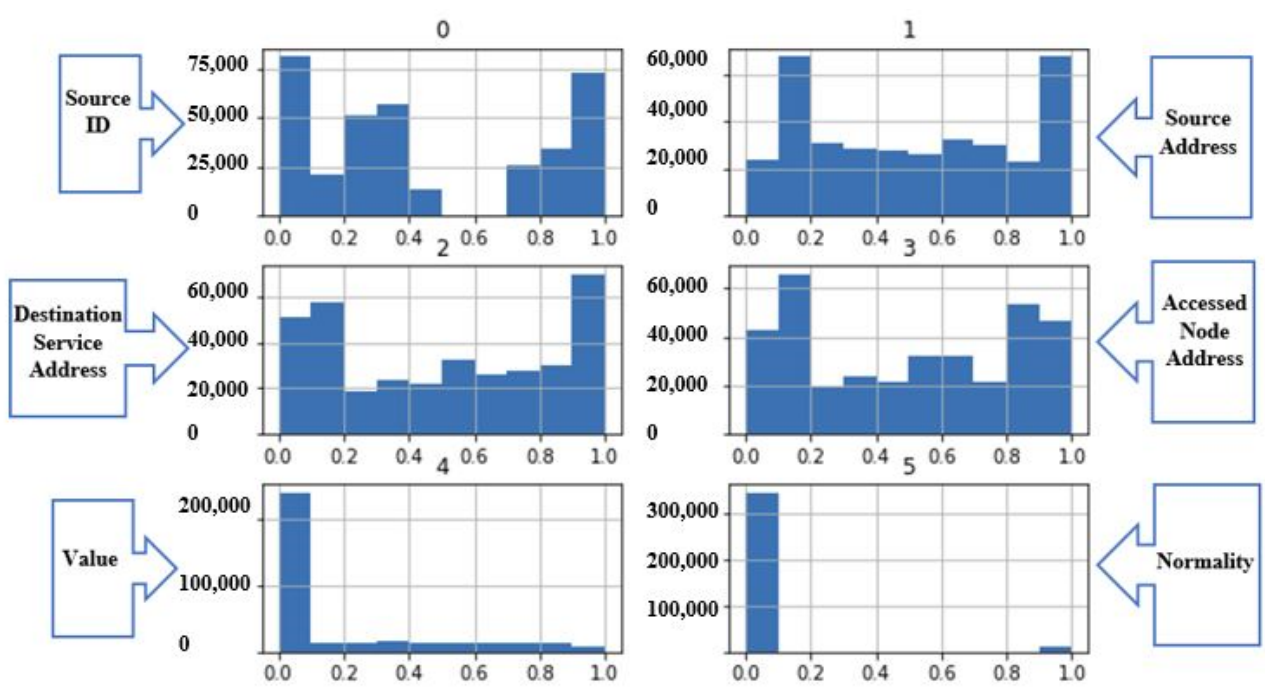
Figure 22. The dataset features distribution after scaling.